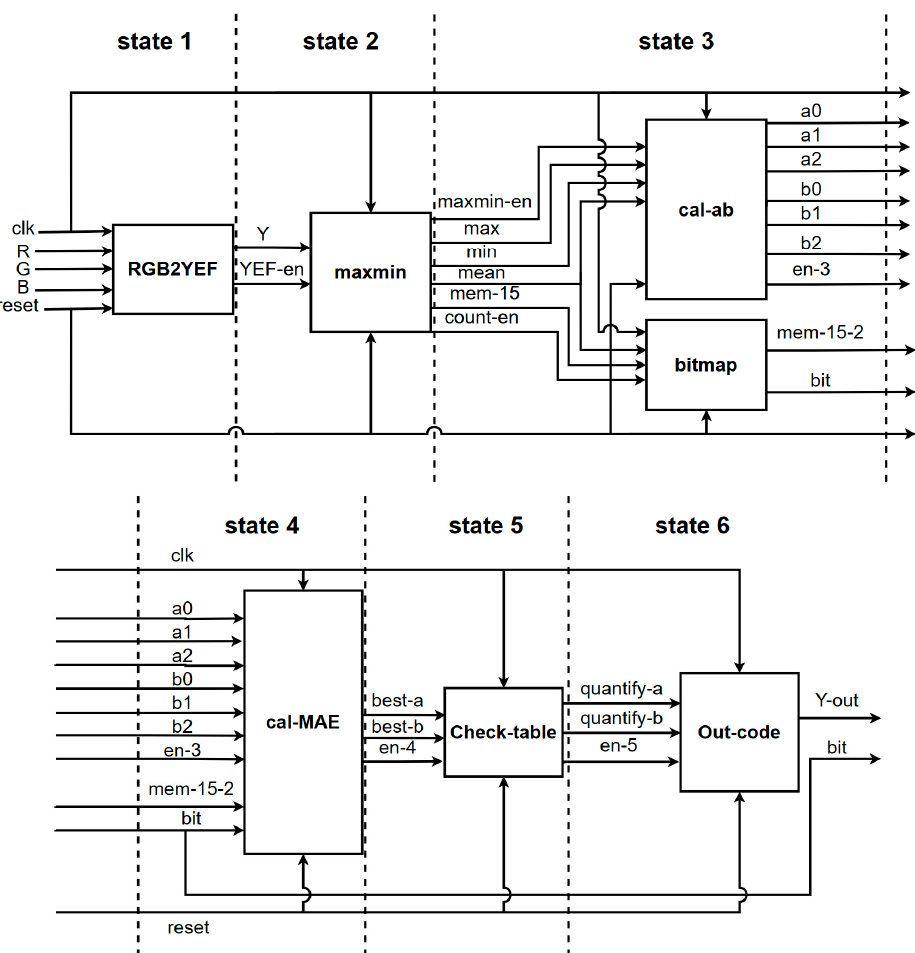
Figure 15. Block diagram of the revised hardware architecture. State 1 is converting RGB color space to YEF color space. State 2 is calculating the max and min of Y. State 3 is calculating the value of reconstruction value and bitmap. State 4 is calculating the MAE which is helpful to decide the best reconstruction value. State 5 is quantizing the reconstruction value. State 6 is coding the reconstruction value with Golomb-rice.